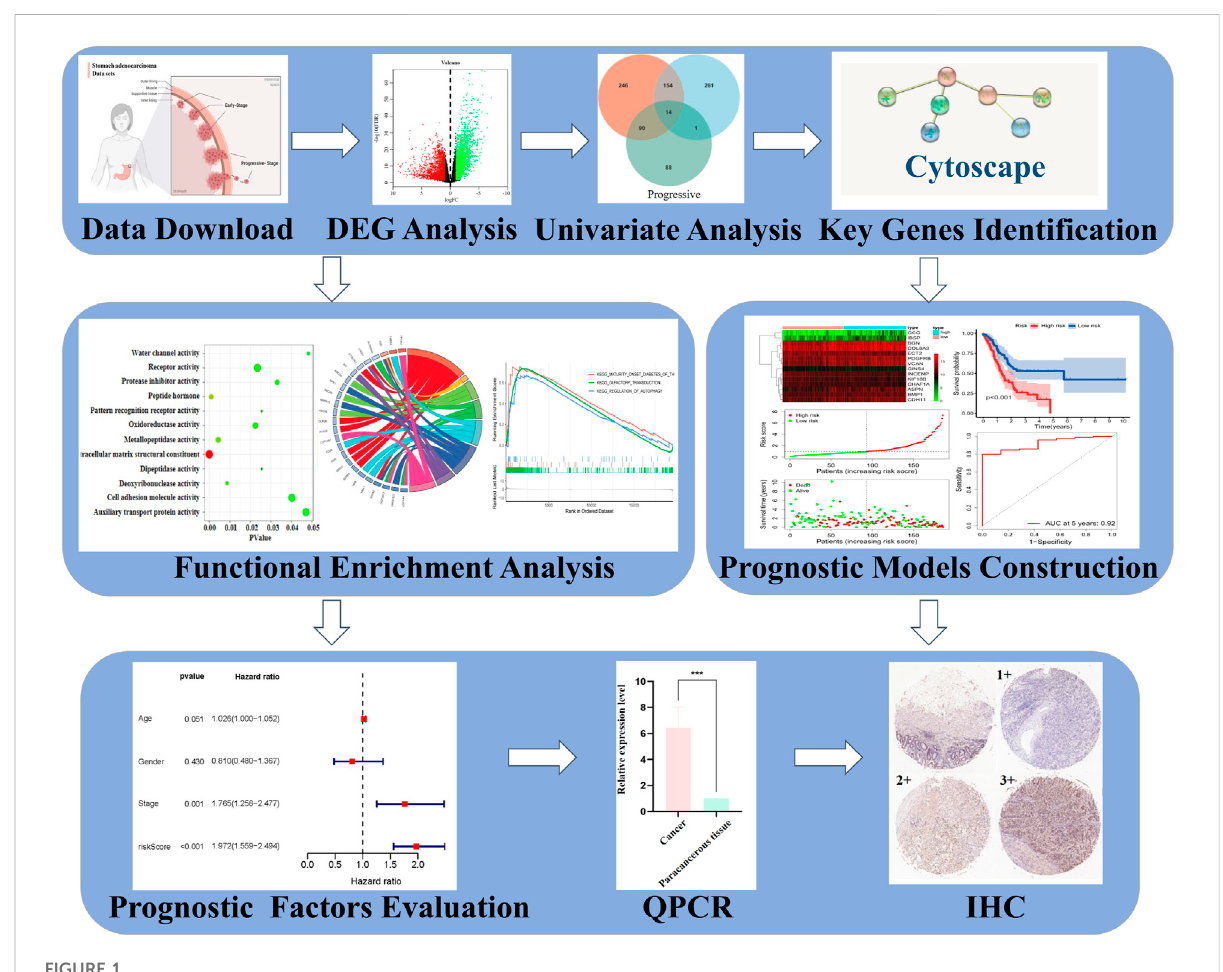
FIGURE 1 Analytic procedures of the